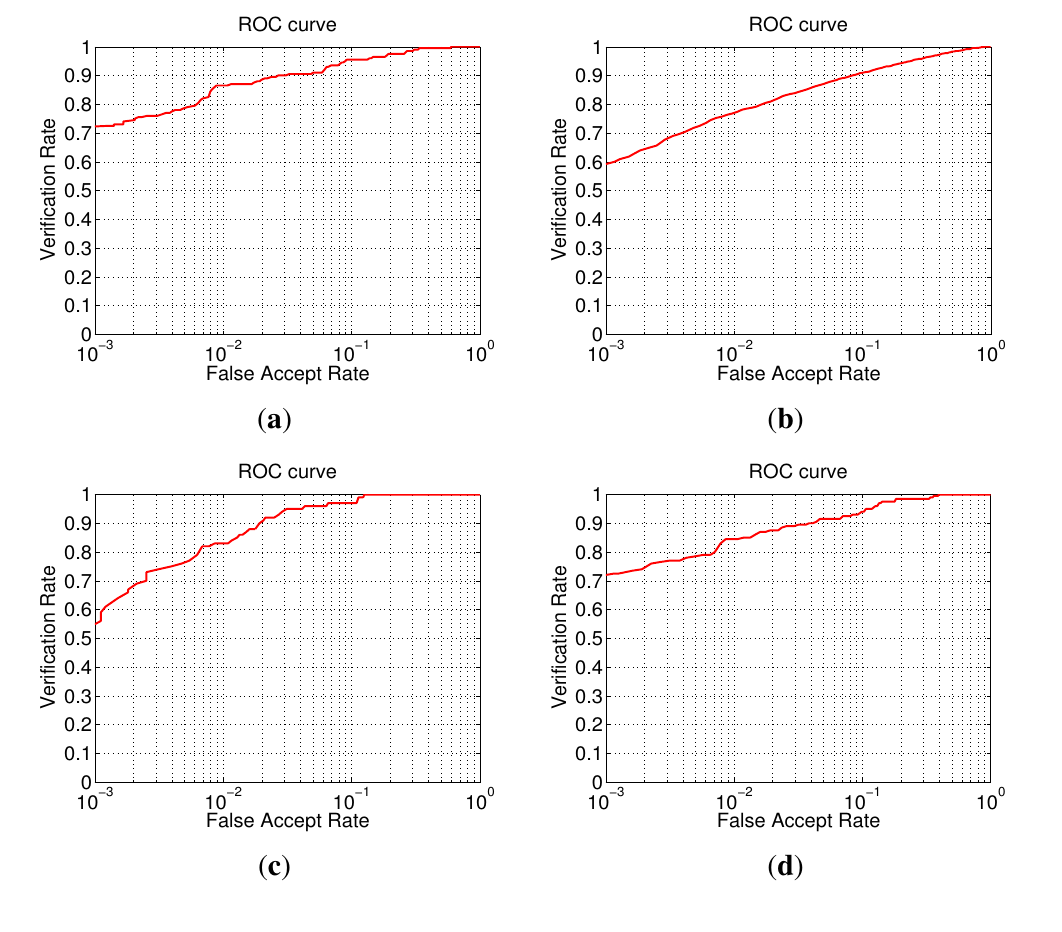
Figure 13. ROC curves of our method on four databases: ( a ) ORL ( p = 2 ); ( b )